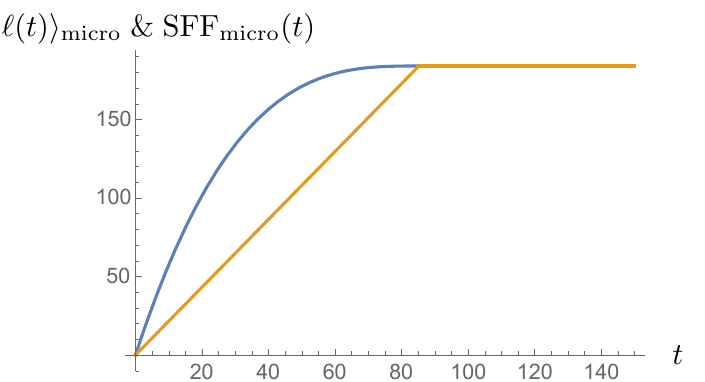
Figure 3 . We show h ‘ ( t ) i micro (blue) and SFF micro ( t ) (orange) for JT gravity with s = 1 (or E = 1 / 2 ). We are plotting the expressions in (5.5), so we have dropped inessential prefactors. h ‘ ( t ) i is a cubic polynomial in time, while the SFF is its second time derivative (up to the addition of a constant). We have normalized h ‘ ( t ) i micro and SFF micro ( t ) in such a way that their plateau values are the